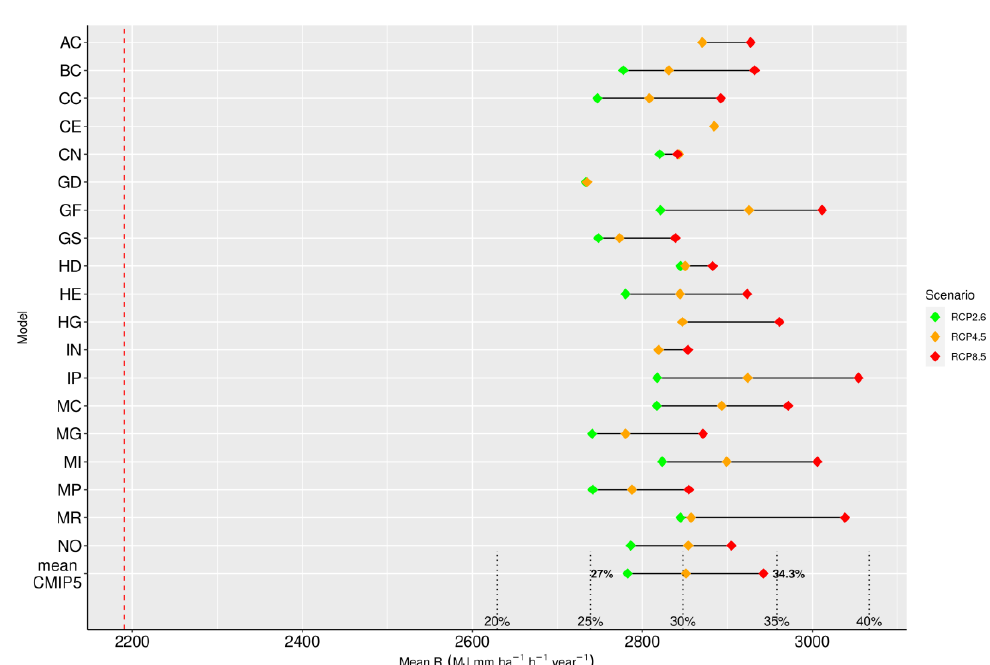
Figure 11. The range of model predictions for years 2050 and 2070 [56].